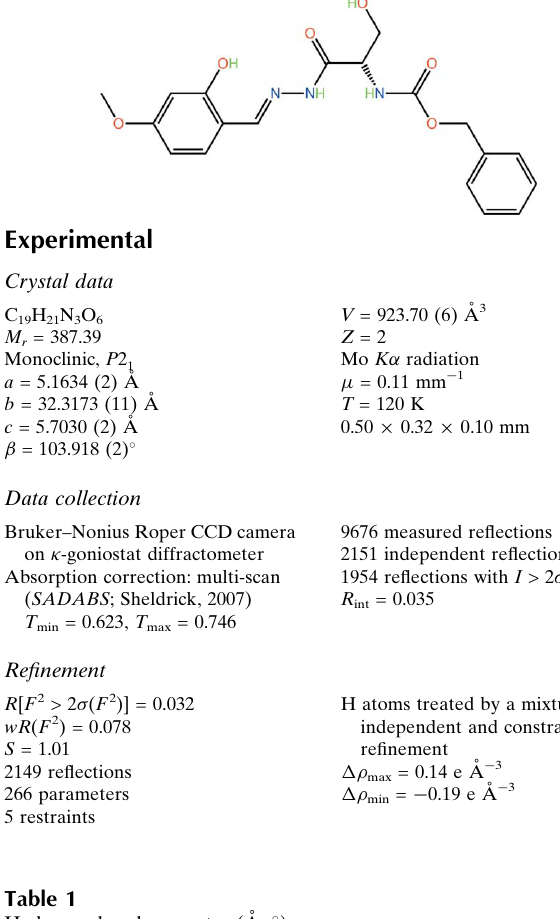
Hydrogen-bond geometry (A˚ , (cid:2) ). Cg 1 is the centroid of the C1–C6